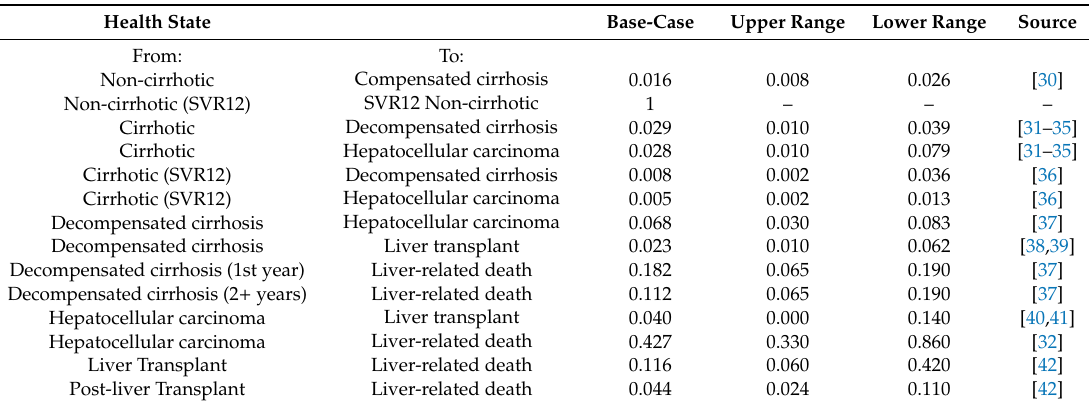
Table 2. Transition